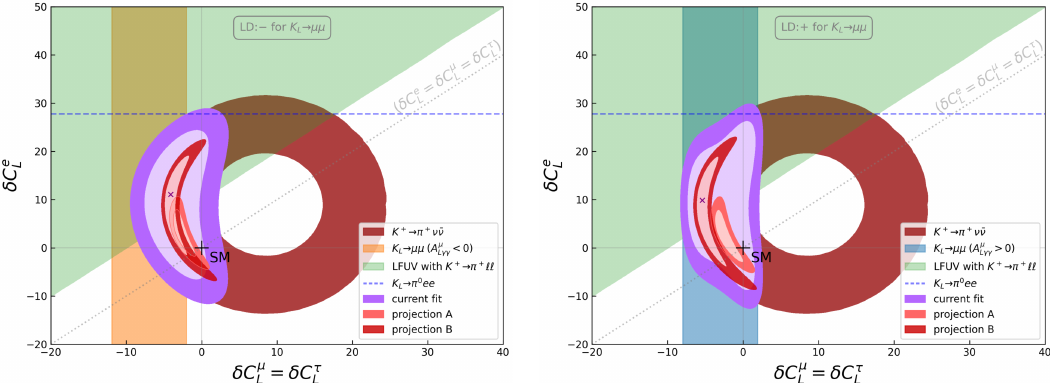
Figure 10 . Global fit with current data (in purple) and projection A (lighter shades of red) and projection B (darker shades of red) together with 68% CL for individual observables with current data. The purple cross indicates the best-fit point with the current